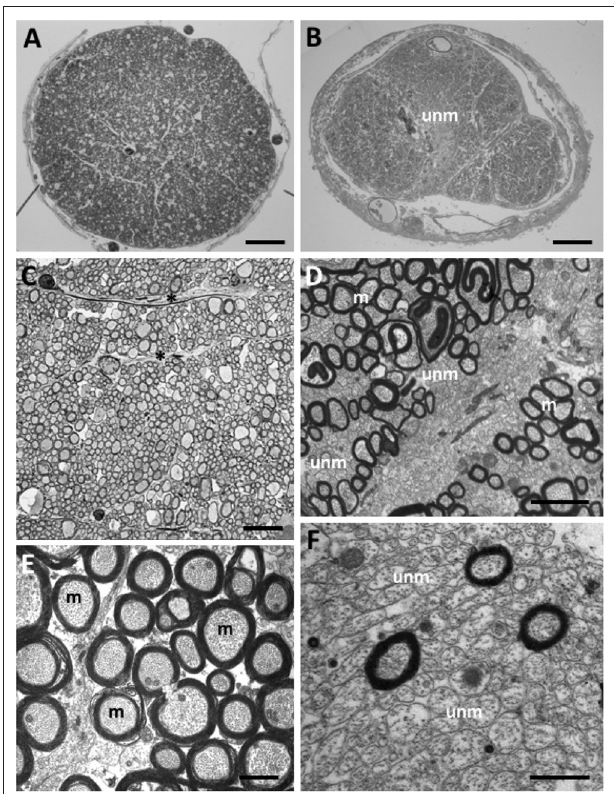
FIGURE 2 | Myelinated and unmyelinated axons in the olfactory tract and optic nerve in Coryphaenoides armatus and C. profundicolus . (A) Light micrograph of the profile of a region of the optic nerve of C. profundicolus (390mm SL) close to the back of the eye. (B) Light micrograph of the profile of a region of the olfactory tract in C. armatus (430mm SL) close to the telencephalon, which appears to be divided into three regions including a central region occupied by high densities of unmyelinated axons (unm). (C) Low power electron micrograph of the optic nerve of C. armatus (900mm SL) showing dense fascicles of myelinated axons separated by astroglial processes (*). (D) Electron micrograph of the olfactory tract of C. armatus (530mm SL) showing a mixture of both myelinated (m) and unmyelinated (unm) axons. (E) Electron micrograph of the optic nerve axons in C. profundicolus (370mm SL) showing the high density of myelinated axons (m). (F) Close up of the high density of unmyelinated axons (unm) in the central region of the olfactory tract of C. armatus (700mm SL). Scale bars: 0.3mm (A) ; 0.2mm (B) ; 8.0 µ m (C) ; 2.0 µ m (D) ; 1.5 µ m (E) ; 2.0 µ m (F)